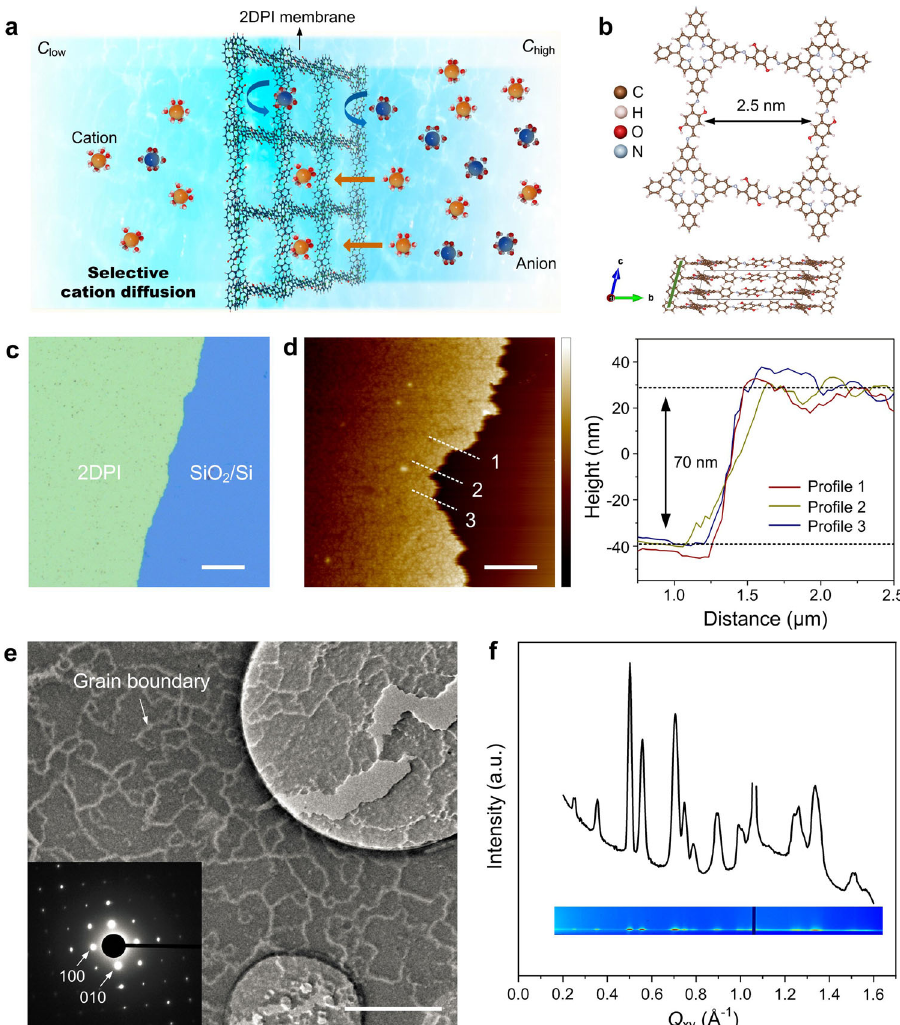
Fig. 1 Ultrathin fully crystalline 2DPI membrane. a Schematic of the selective ion diffusion process across the 2DPI membrane. b The structure of the 2DPI membrane as well as its most stable stacking mode (inclined AA stacking). c The optical microscopy image of the 2DPI membrane (scale bar: 50 µ m). d AFM of the 2DPI membrane on 300 nm SiO 2 /Si, revealing an ultrathin thickness of about 70 nm (scale bar: 300 nm; color bar: − 59.2 to 66.8 nm). e TEM images and SAED pattern of the 2DPI membrane, indicating its excellent crystallinity on the microscale (scale bar: 800 nm). f In-plane intensity pro fi le of a 2DPI membrane. The inset shows the in-plane peaks from the 2D GIWAXS